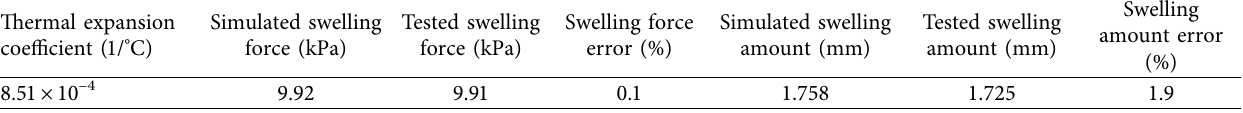
Table 2: Inversion of thermal expansion coefcient of expansive soil.